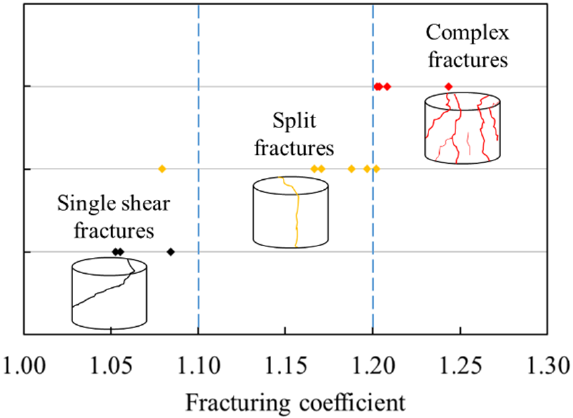
Figure 4. Core fracture morphology under different fracturing coefficients. Black dots represent single shear fractures, yellow dots represent split fractures, and red dots represent complex fractures. Table 3. Analysis of influencing factors of rock fracture